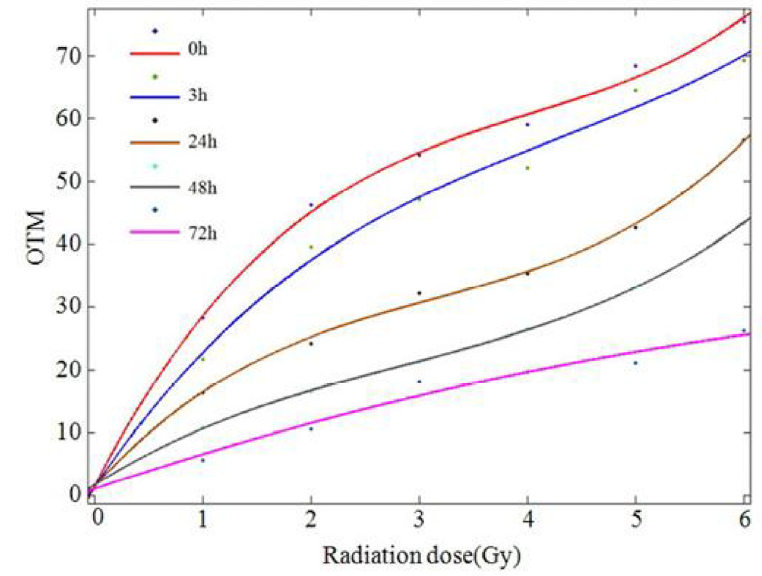
Figure 5. Dose-response curves of OTM obtained from the comet assay within 72 h after irradiation. [Dose-effect equations for different time points are shown below: “ y ” is the observed value of OTM; “ x ” is the radiation dose (Gy)]. Fit 1: y = 0.5789 x 3 − 6.968 x 2 + 0h = 0.3397 x 3 − 4.364 x 2 + 25.4 x + 1.43 33.37 x + 1.615 ( R 2 = 0.9979, p = 0.000); Fit 2: y 3h ( R 2 = 0.9939, p = 0.000); Fit 3: y = 0.4908 x 3 − 4.614 x 2 + 19.16 x + 1.489 ( R 2 = 0.998, 24h p = 0.000); Fit 4: y = 0.2647 x 3 − 2.257 x 2 + 10.95 x + 1.76 ( R 2 = 0.9999, p = 0.000); 48h = 0.002222 x 3 − 0.304 x 2 + 5.818 x + 1.156 ( R 2 = 0.9777, p = Fit 5: y 72h